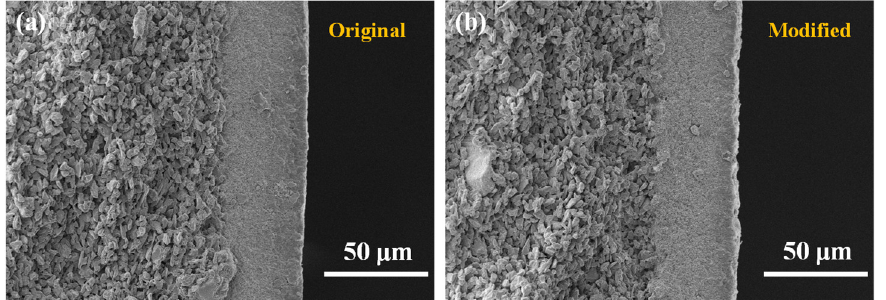
Figure 5. Scanning electron microscope (SEM) images of the α -Al 2 O 3 membrane ( a ) before and ( b ) after modification.